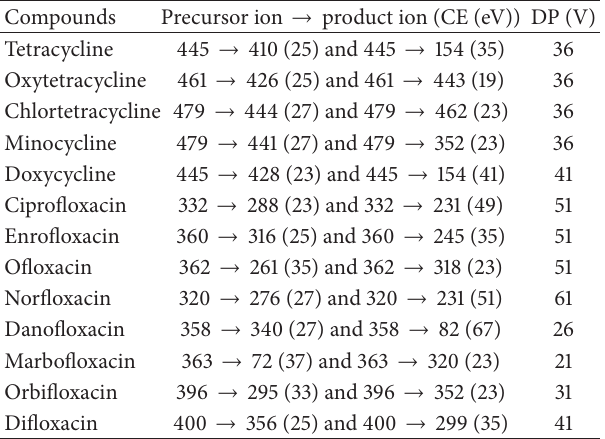
Table 2: Precursor and product ions, collision energy (CE), and declustering potential